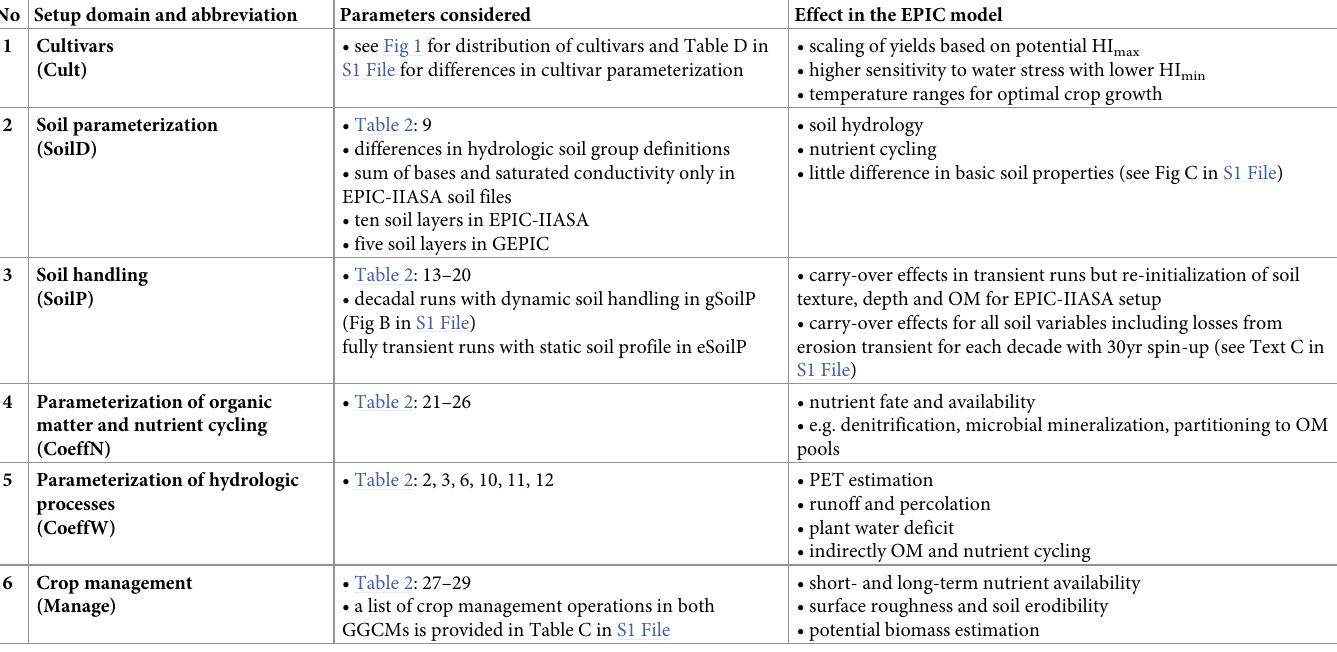
Table 3. Composition of aggregated setup domains the comparison of GEPIC in EPIC-IIASA in the fully harmonized (fullharm) scenario (Table 1). Numbers in the first column are used in selected figures to keep annotation short, otherwise the abbreviation is used. Numbers in column “Parameters considered” refer to those in Table 2. When referencing the setup domain parameterizations from each GGCM, e = EPIC-IIASA and g = GEPIC (e.g. eCult refers to cultivar setup of EPIC-IIASA). No Setup domain and